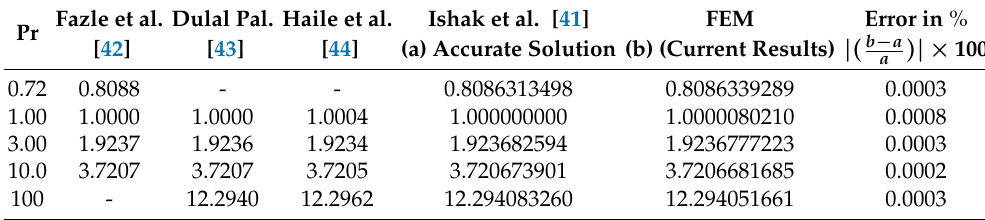
Table 5. Assessment of − θ (cid:48) ( 0 ) for numerous values of Pr when β ∗ → ∞ . Fazle et al. Dulal Pal. Haile et Pr